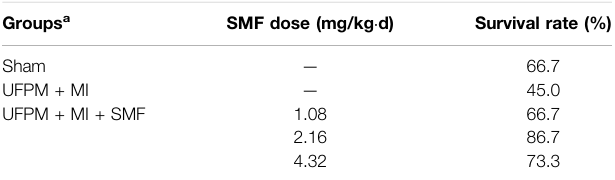
TABLE 1 | Survival rates (%) after SMF pretreatment in UFPM-exposed rats with MI. Groups